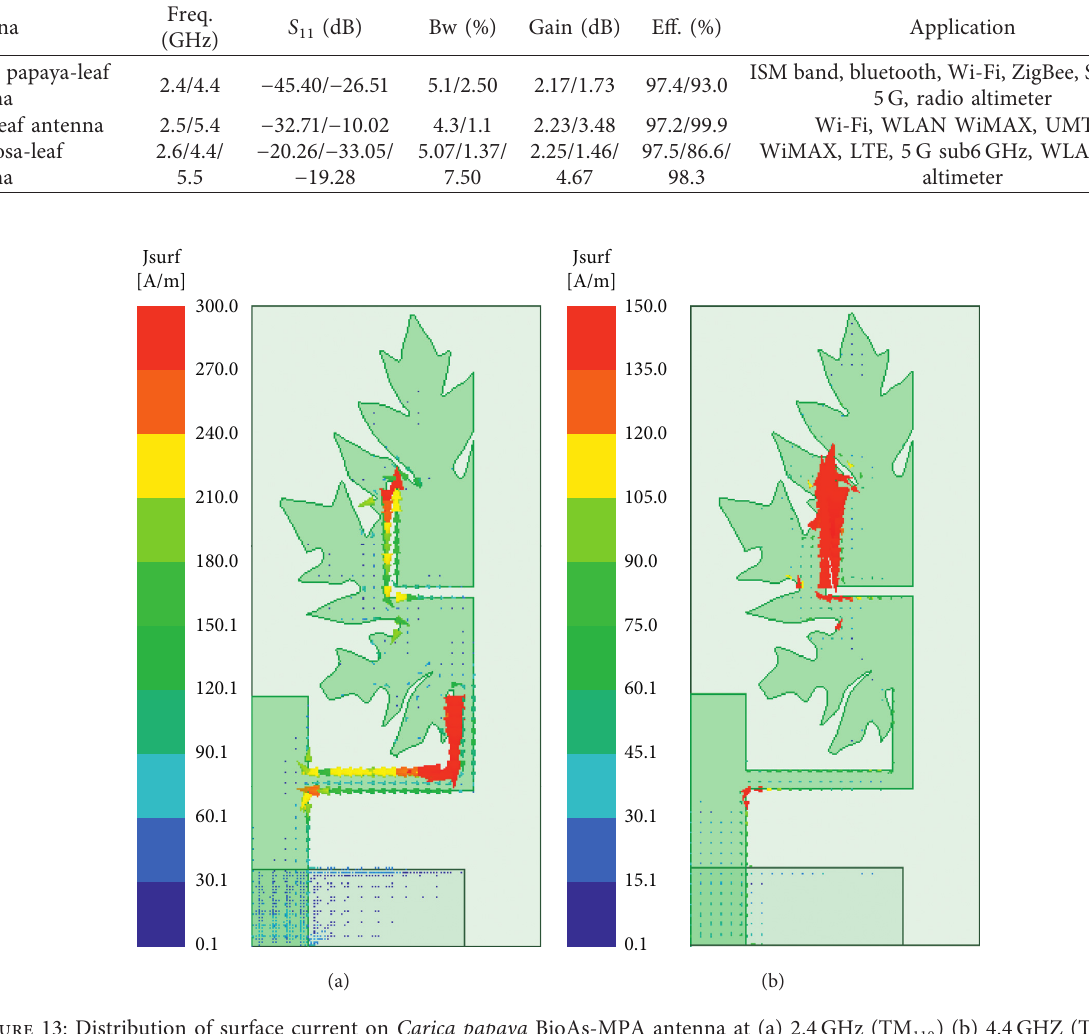
) (b) 4.4GHZ (TM 110 210